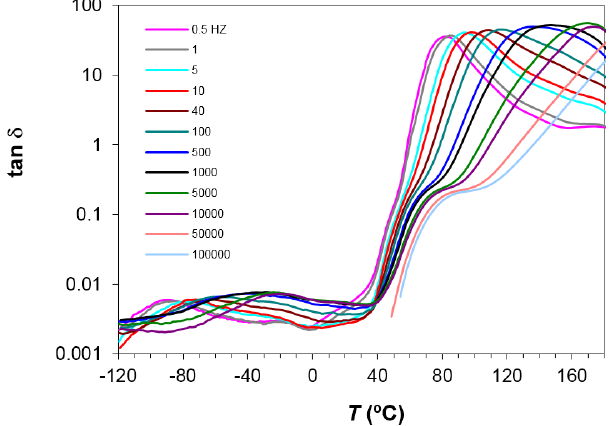
Figure 13. Dielectric relaxation spectroscopy curves for PEI800-PLA5 at 0.5 °C/min for frequencies between 0.5 Hz and 100 kHz. Figure 14: at 1 Hz and 2 °C/min, the γ -relaxation appears a − 90 °C for PEI800-PLA5, at − 95 °C for PEI2000-PLA5, and at − 97 °C for PEI2000-PLA20. Figure 9 compares the γ -relaxation for all three